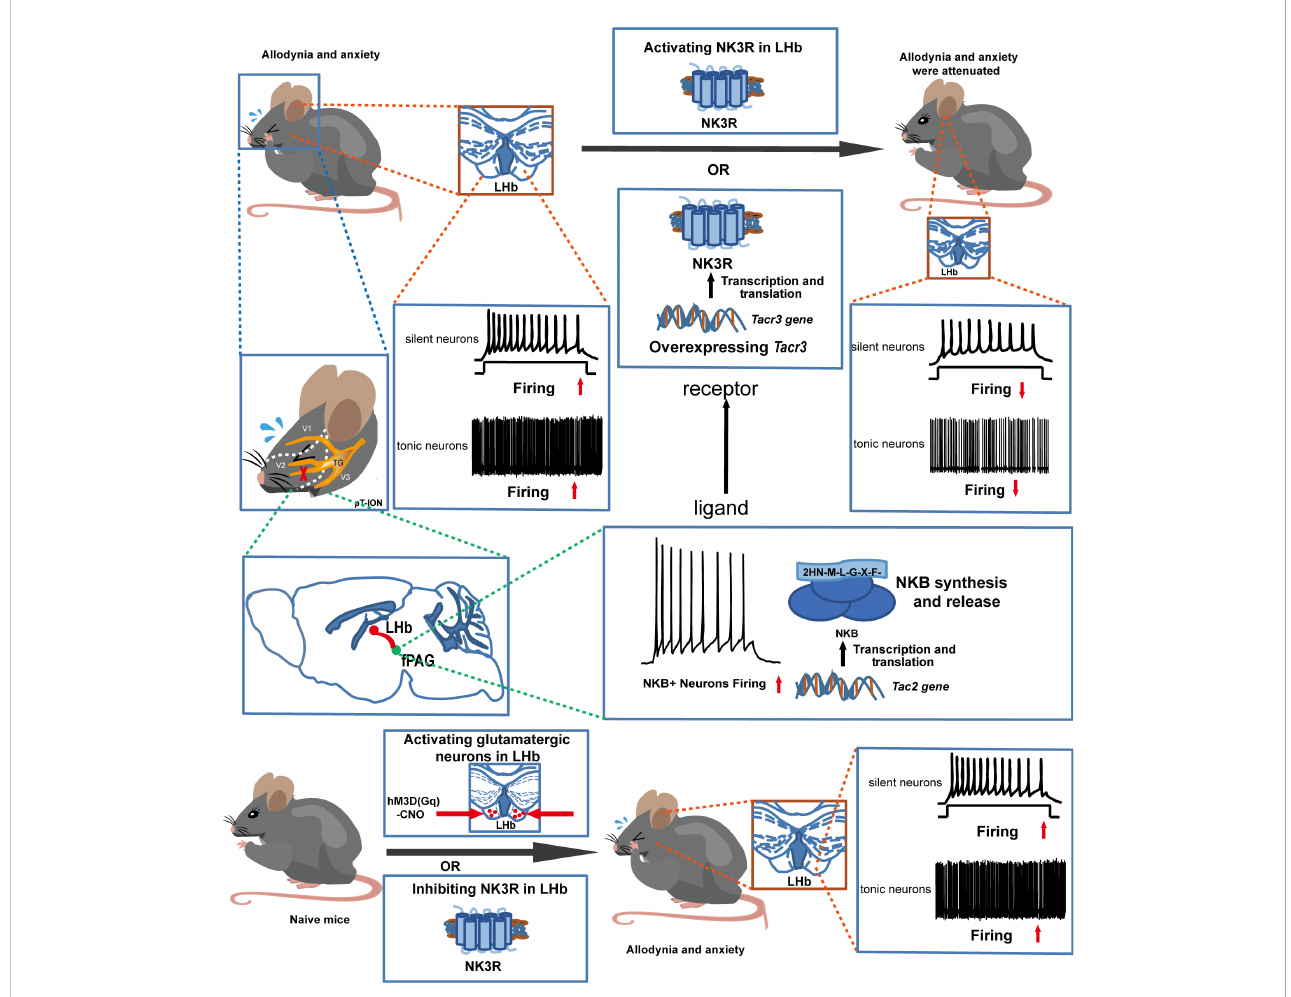
FIGURE 11 Schematic diagram of the role of NK3R in the LHb in the development of orofacial allodynia and comorbid anxiety. Under normal physiological conditions, NK3R in the LHb is protective. Trigeminal nerve injury leads to the downregulation of NK3R, and thus the orofacial allodynia and anxiety-like behaviors are induced due to the hyperactivity of LHb neurons. Its ligand NKB is mainly from the fPAG, and fPAG NKB ! LHb projections regulate orofacial allodynia and comorbid